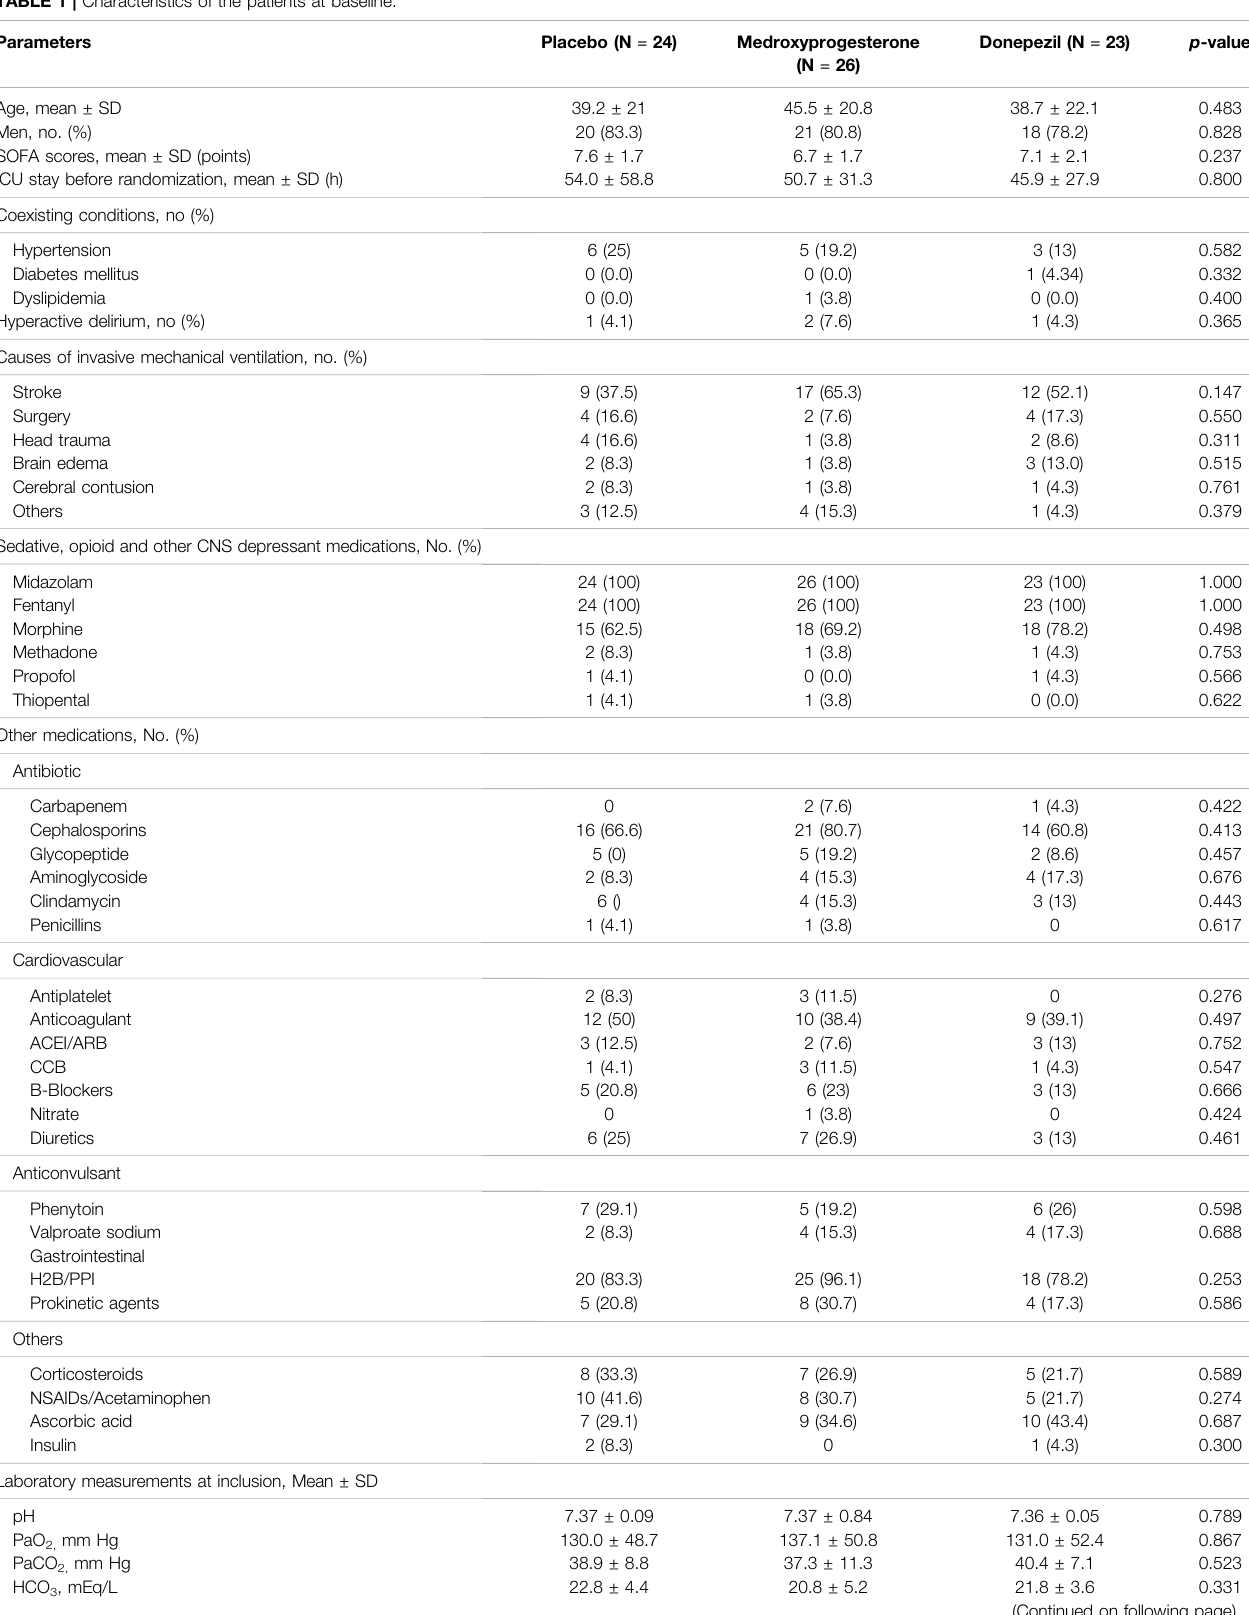
TABLE 1 | Characteristics of the patients at